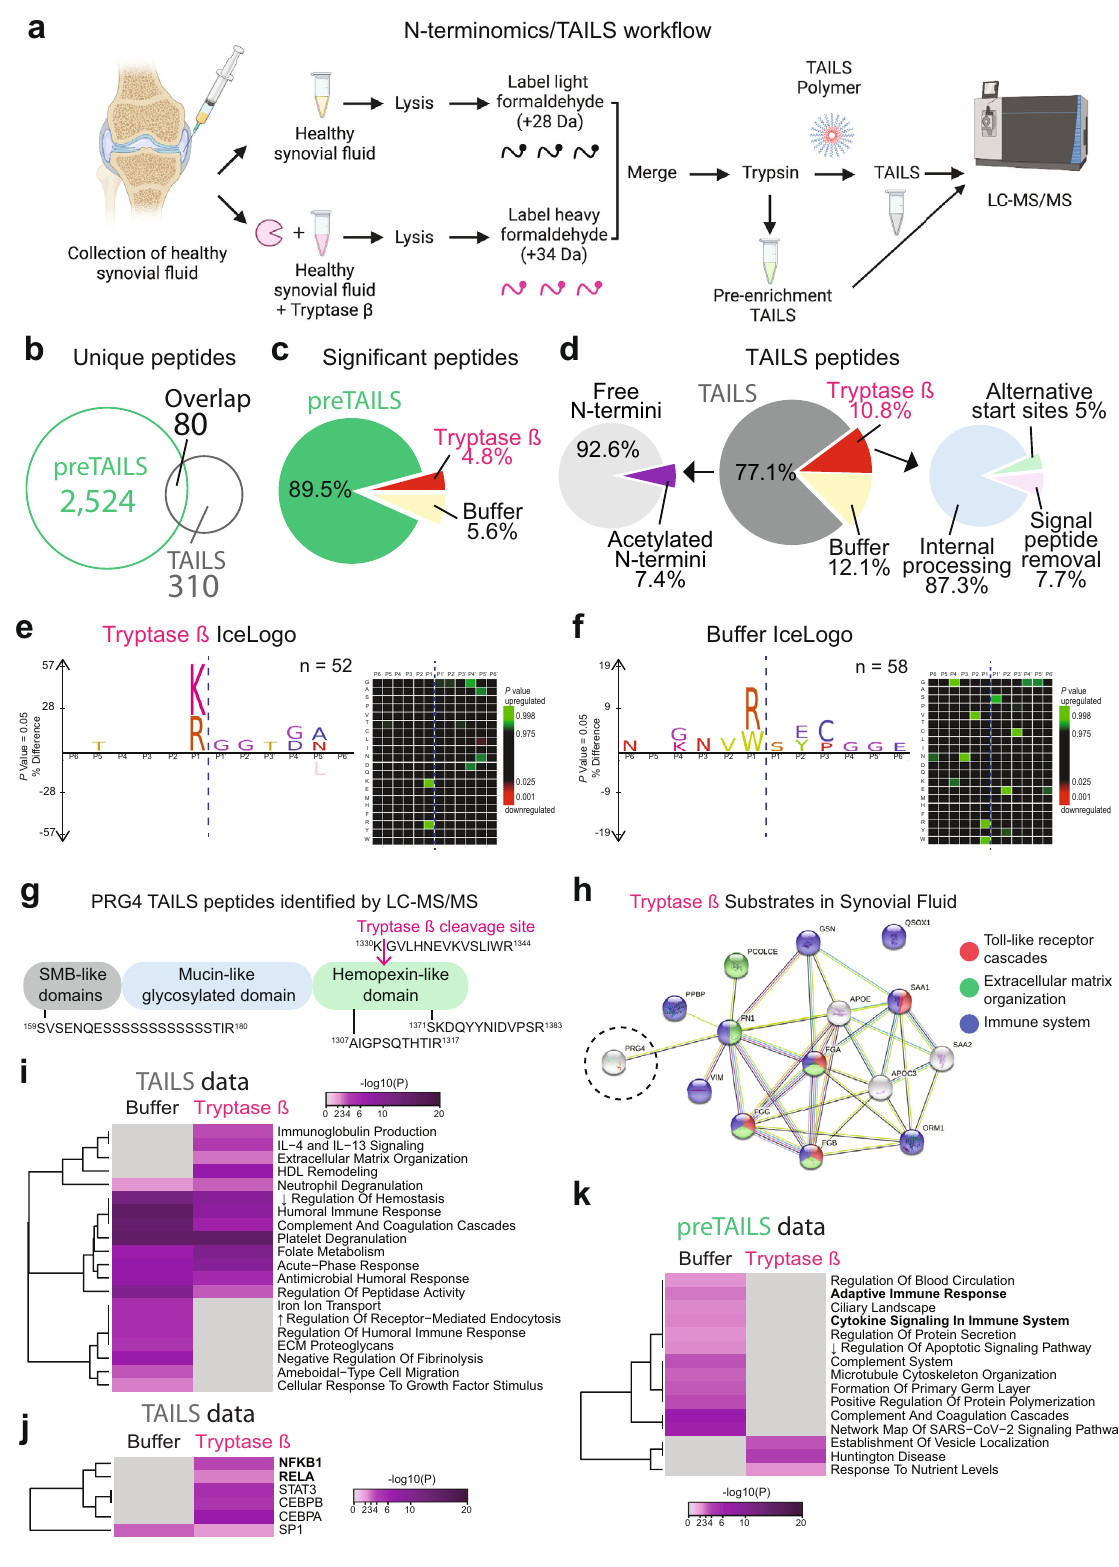
Single-cell RNA sequencing cell-cell interaction analysis SquidPy was applied to characterize cell-cell interaction 81 , which pro- vides an analytical method for storing, manipulating, and interactively visualizing single-cell RNA sequencing data. It re-implements the CellPhoneDB method 82 that is capable of handling a high number of interacting pairs (>100,000) and cluster combinations (>100).